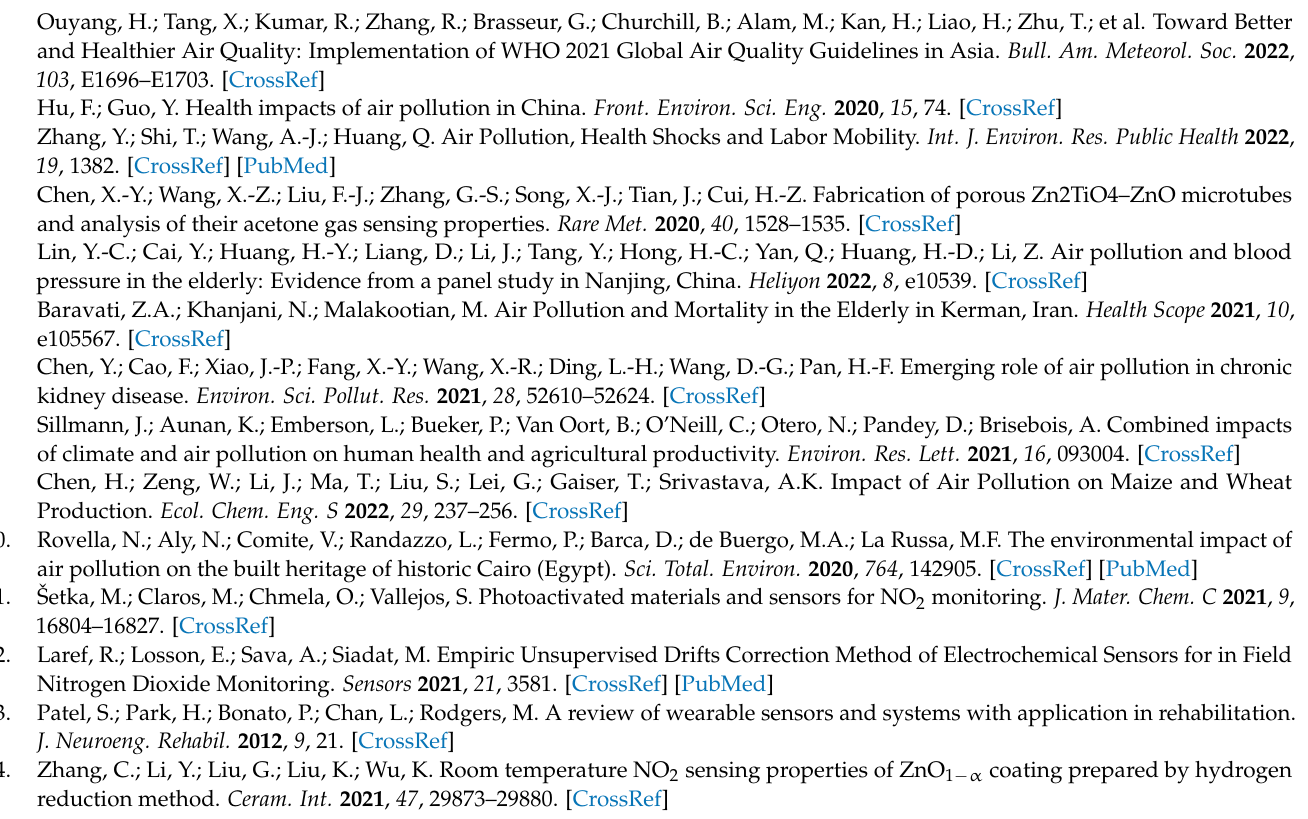
Figure S2: The contribution of countries in the field of artificial intelligence in gas-sensor designing; Figure S3: The FESEM characterization of Fe 3 O 4 -rGOQD-SO 3 H as NO 2 gas sensor in this research; Table S1: The outcomes of descriptive statistical analysis of response time and sensitivity; Table S2: ANOVA results of the quadratic model for response time answer; Table S3: ANOVA results of the cubic model for sensitivity